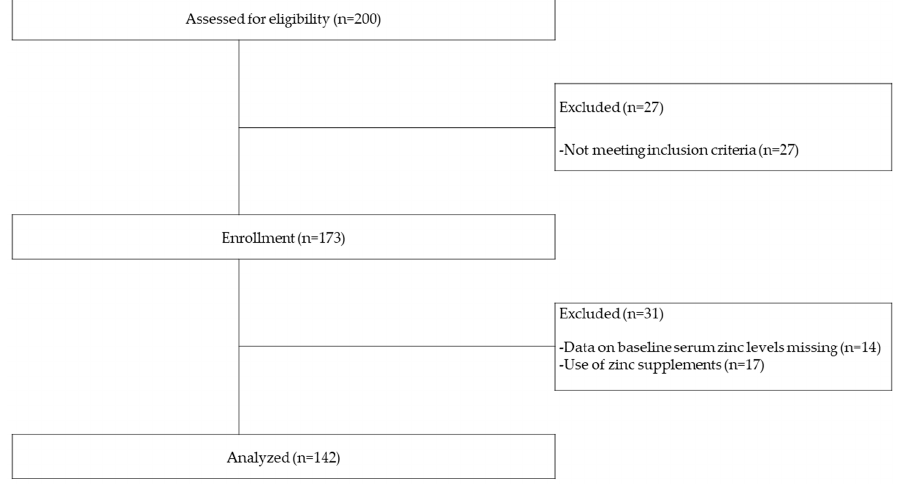
Figure 1. Flow of patients through the study .